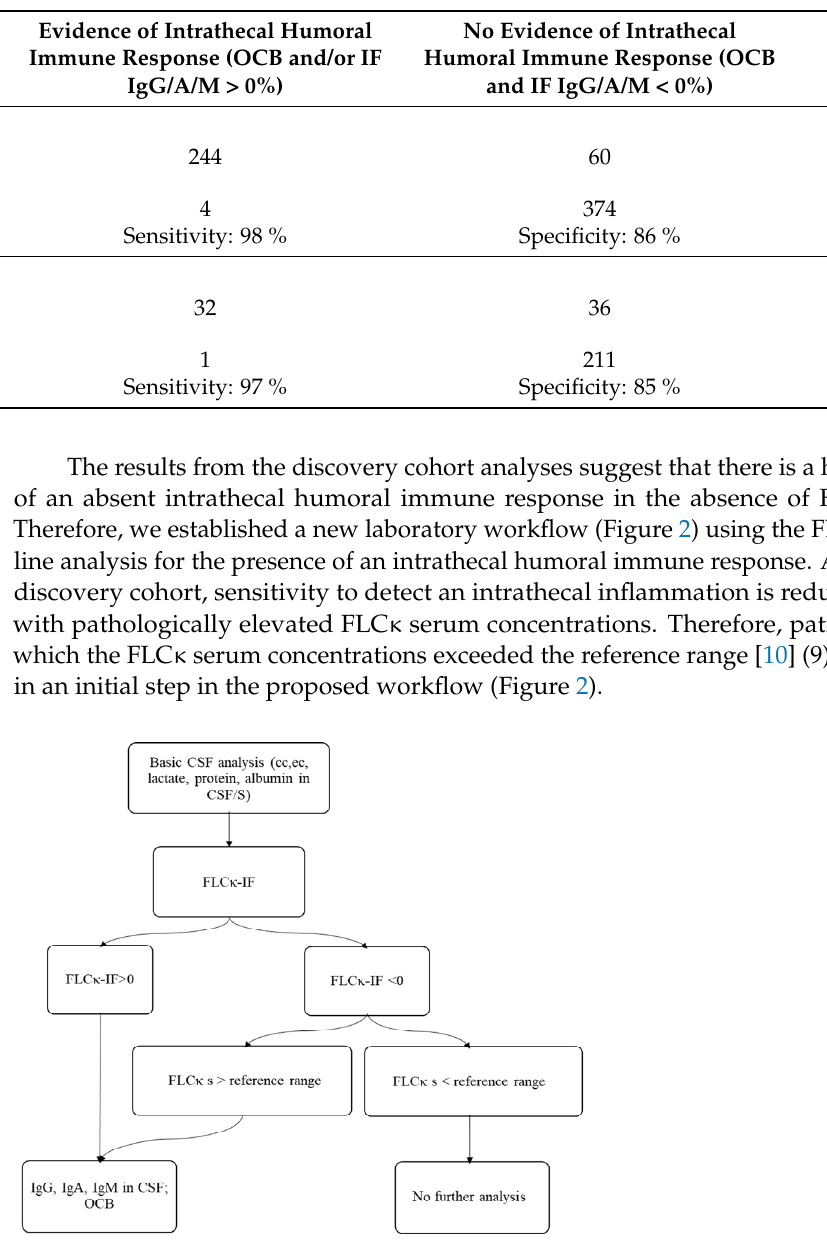
Figure 2. The suggested algorithm for the integration of the FLC κ -IF into the CSF laboratory work- flow. After determination of cell count, erythrocyte count, lactate, and total protein, FLC κ is measured in CSF and serum and the quotient is evaluated in relation to the hyperbolic reference range. If the FLC κ -IF is >0, further analysis of immunoglobulin and OCB should be performed. If the FLC κ -IF is <0 and the serum concentration of FLC κ is normal, further analysis of Ig and OCB can be omitted. EC: erythrocyte count; OCB oligoclonal bands, Ig immunoglobulin, CSF cerebrospinal fluid, FLC κ free light chains kappa, cc cell count.